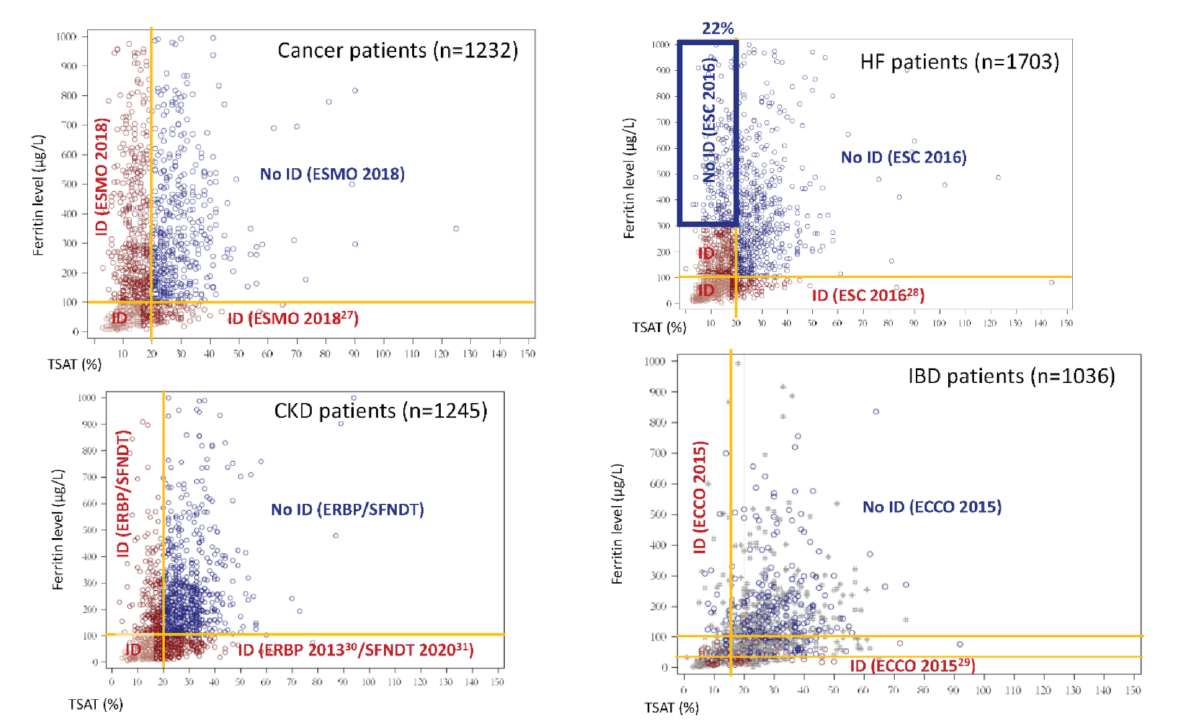
Figure 2. Distribution of ferritin concentration and TSAT index in the four types of CARENFER patients. Red dots represent iron-deficient patients based on ESMO 2018 guidelines (for cancer patients) [27], ESC 2016 guidelines (for HF patients) [28], ECCO 2015 guidelines (for IBD patients) [29], and ERBP 2013 [30] and SFNDT 2020 [31] recommendations (for non-dialysis CKD patients). Blue dots represent patients with no ID based on ESMO, ESC, ECCO, and ERBP/SFNDT definitions. Grey dots represent IBD patients with both undetermined CRP concentration and